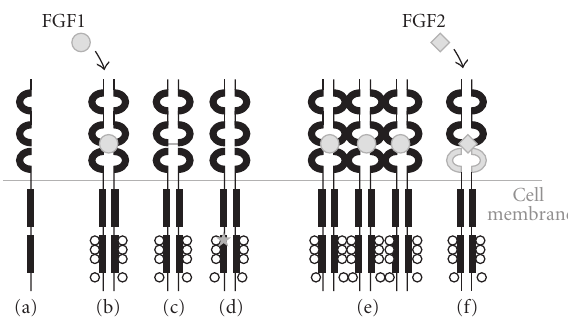
Figure 2: Mechanisms of physiological (a)-(b) and pathological (c)–(f) activation of FGFR3. (a) Monomeric inactive receptor; (b) Ligand-dependent dimerization and activation; (c) Ligand- independent dimerization and activation induced by mutation of the extracellular portion; (d) Ligand-independent activation due to mutations of the tyrosine-kinase domain; (e) Upregulation of signalling due to receptor overexpression; (f) Alteration of splicing favouring isoforms with broader ligand